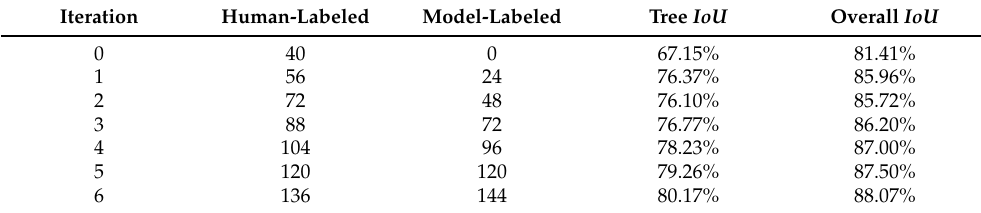
Figure 7. The relationship between entropy, accuracy and image mask selection based on semisuper- vised active learning with a 60% strategy. Each green point represents one image. Points covered by the shaded blue area are accepted model predictions. Points shaded red were selected to be labeled by hand. Table 3. Number of labeled masks and accuracy during semisupervised active learning with the 60% selection